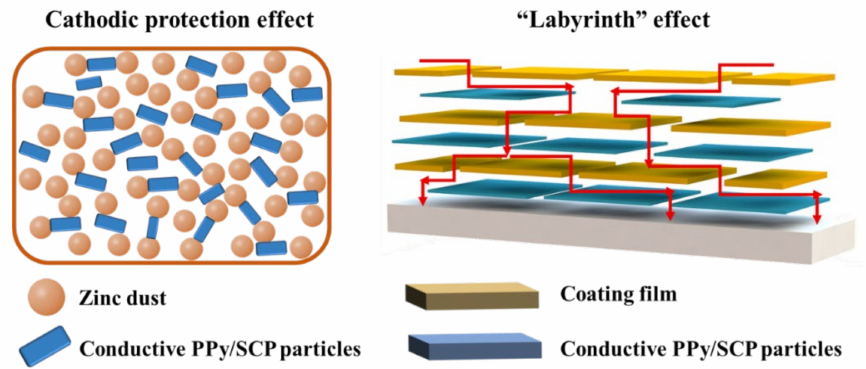
Figure 13. Schematic diagram of anticorrosion mechanism of ZRP coatings with conductive PPy/ SCP